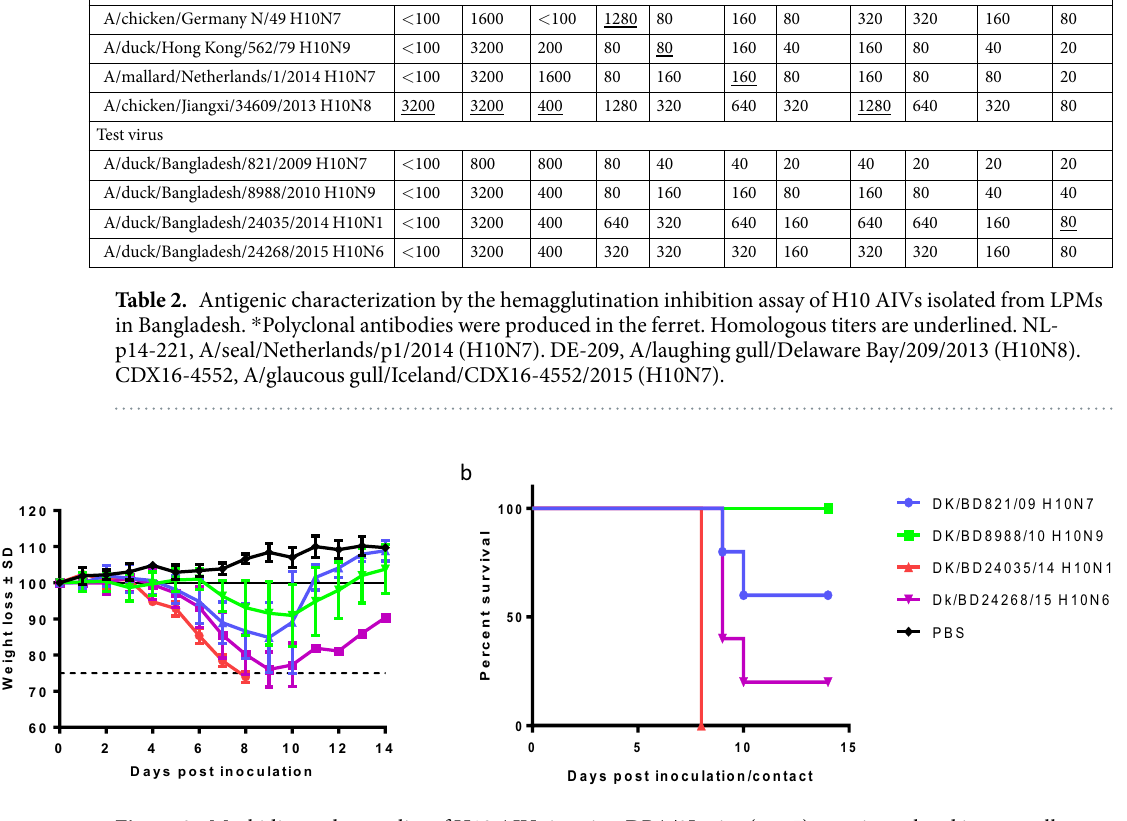
Figure 2. Morbidity and mortality of H10 AIVs in mice. DBA/2J mice (n = 5) were inoculated intranasally with 30 μ L of 10 6 EID 50 DK/BD821/09 H10N7, DK/BD8988/10 H10N9, DK/BD24035/14 H10N1, or Dk/